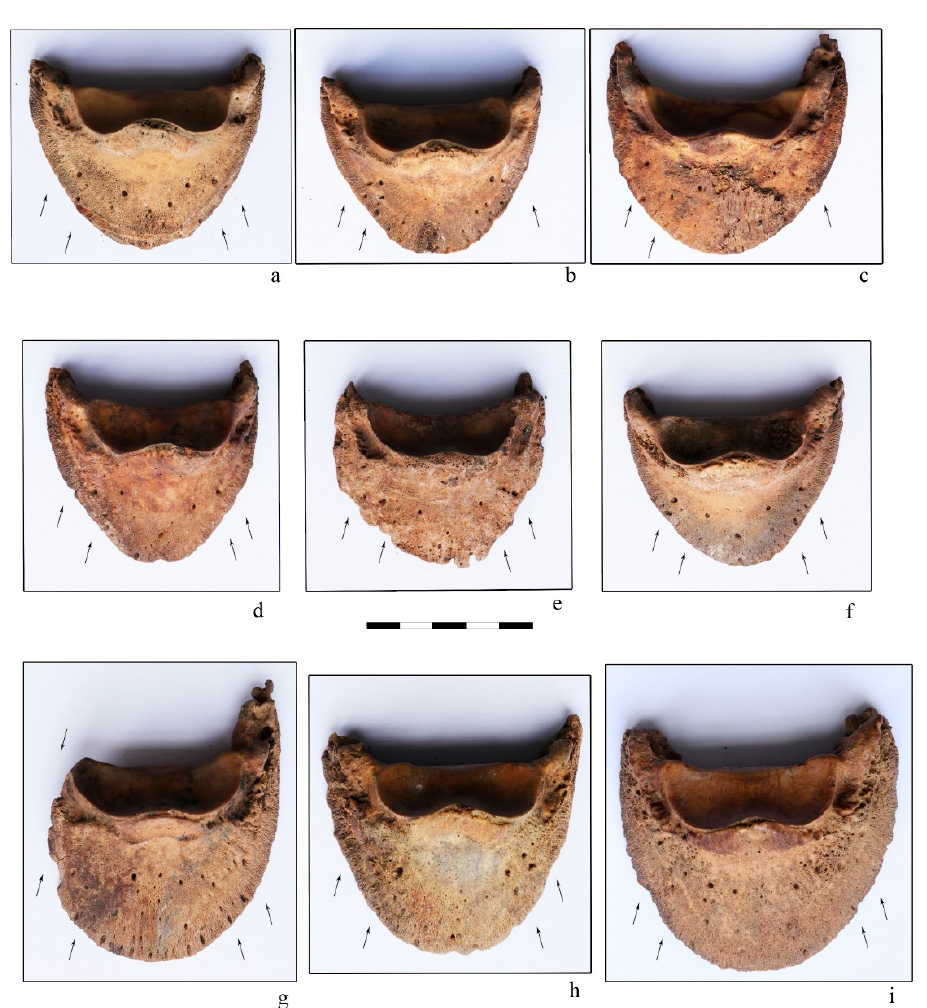
Figure 4. Wroclaw Ostr ó w Tumski. Horse distal phalanx with a removed hoof capsule ( a – i ), arrows indicate the traces of cutting the entire distal part (solear margin) of the ungular (co ffi n)